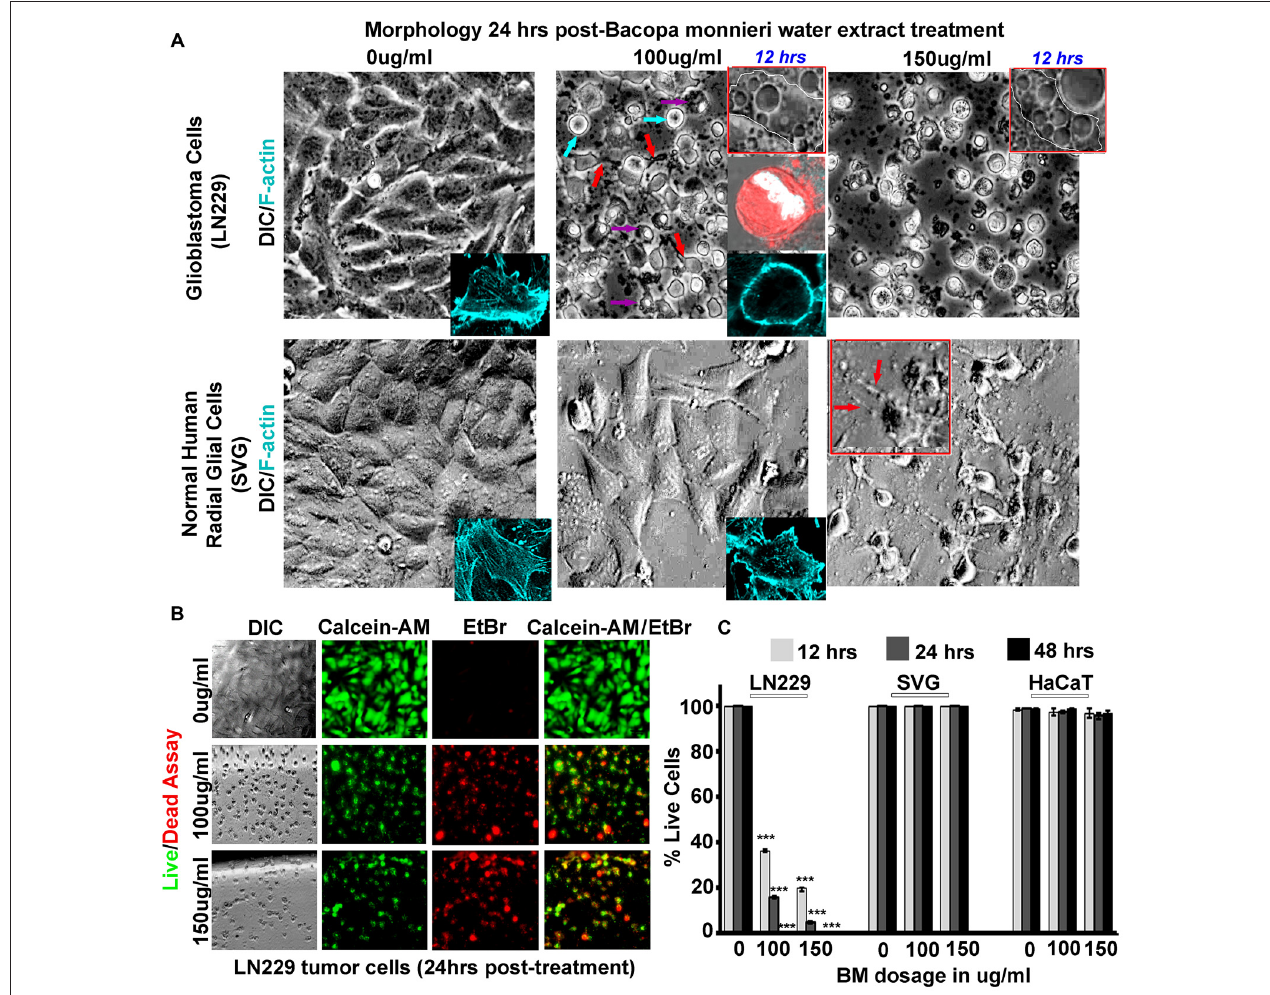
FIGURE 4 | Bacopa monnieri (BM) a known inducer of CaMK2A phosphorylation generates glioblastoma cytotoxicity. (A) BM extract, an inducer of CaMK2A phosphorylation, was administered to LN229 glioblastoma tumor cell line cultures in various doses and monitored at various time points. Human normal radial glial cells (SVG) were used as normal controls. Top insets in middle and last panels of LN229 shows that BM treatments (100 µ g/ml and 150 µ g/ml), within 12 h, induced phased lucent enlarged vacuoles in cells, characteristic of macropinosomes, also see Supplementary Figure S5A for confirmation of macropinocytotic vacuoles. Second inset in the middle panel of LN229 shows Dextran TMR (red, which is uptaken by macropinosomes and released into the cytoplasm) filled, rounded and swelled tumor cell with squashed nucleus (white, due to raised hydrostatic pressure of intracellular fluid) in 24 h post treatment, please see Supplementary Figure S5B for more detailed images. Last inset shows loss of cell actin cables (rhodamine phallodin staining shown in cyan) due to cell swelling. The comparative analysis of main panels on the basis of morphology and F-actin staining suggests no cytotoxicity to normal cells, however, LN229 cells showed cell rounding (cyan arrows), cell swelling, nuclear compression (magenta arrows) and cell necrosis (red arrows), post 24 h of treatment. A dose of 150 µ g/ml showed SVG differentiated phenotype, hence the therapeutic dose was determined to be 100 µ g/ml. (B,C) Calcein-AM (green, live cell marker probe)/EtBr (red, damaged and dead cell marker dye) based cytotoxicity and viability analysis over various time points (12, 24 and 48 h) post BM treatment at 0, 100 and 150 µ g/ml showed specific cytotoxic effects on LN229 glioblastoma cell lines vs. the normal cells (SVG and HaCaT). ∗∗∗ p < 0.001. Error bar = SD The analysis is representative of three independent